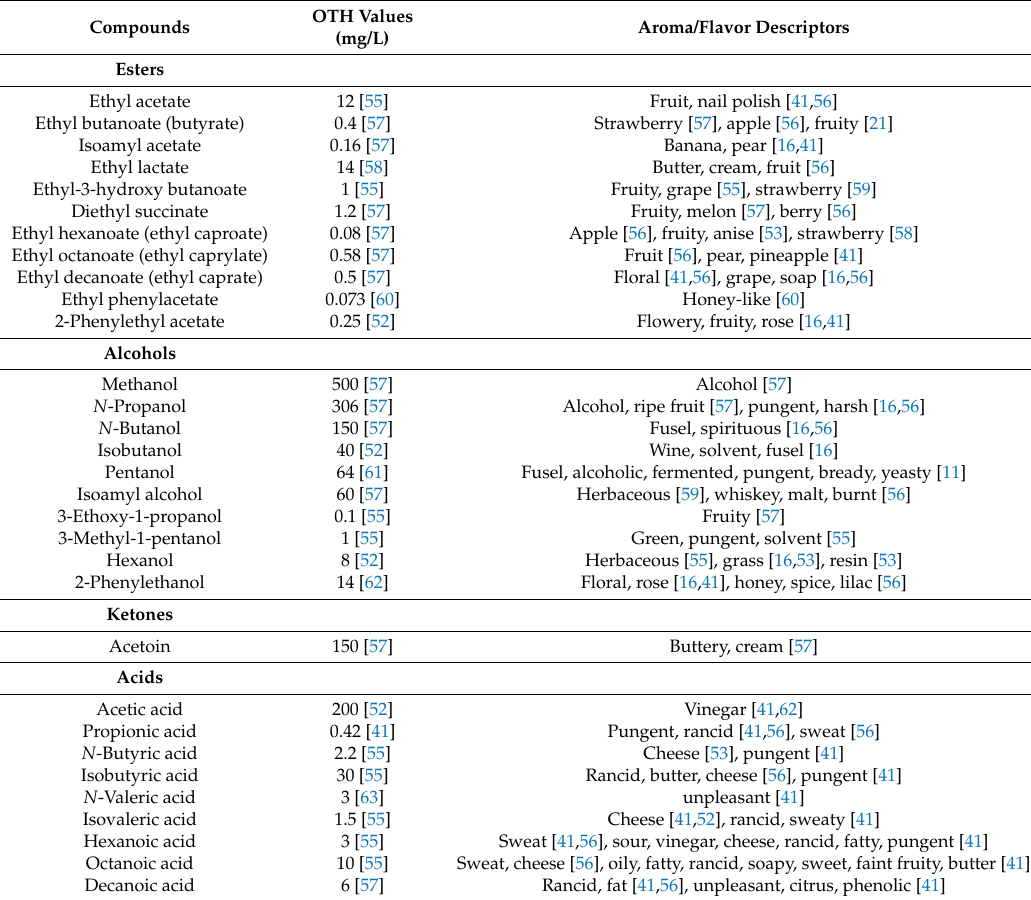
Table 4. Odor threshold (OTH) values (mg/L) and descriptions of aroma and flavor compounds found in wine. Superscript values denote the appropriate